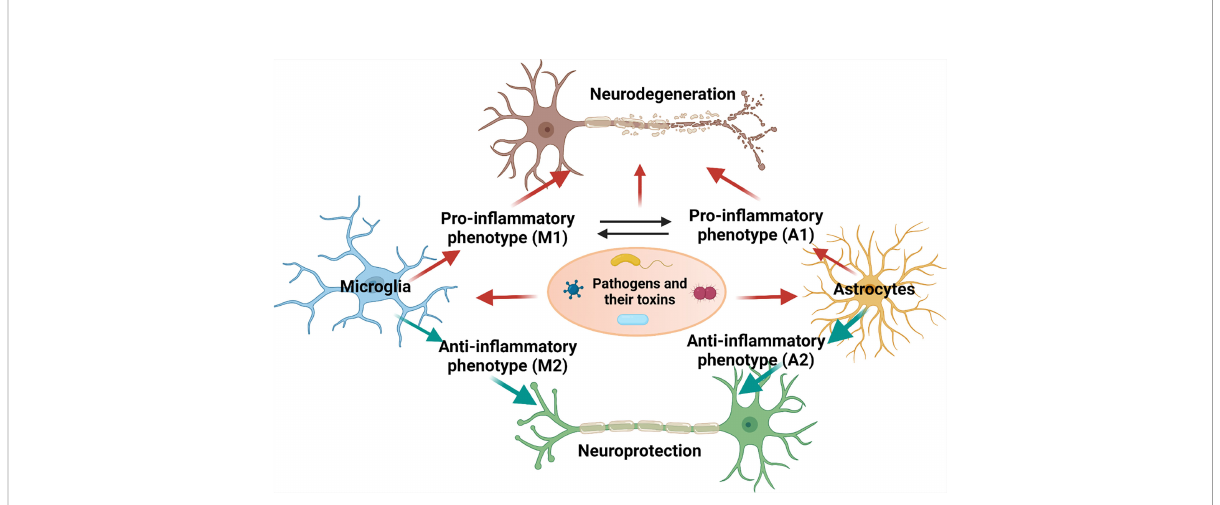
FIGURE 2 Polarization of microglia and astrocytes and their role in causing neurodegeneration upon microbial infection. This fi gure was illustrated using